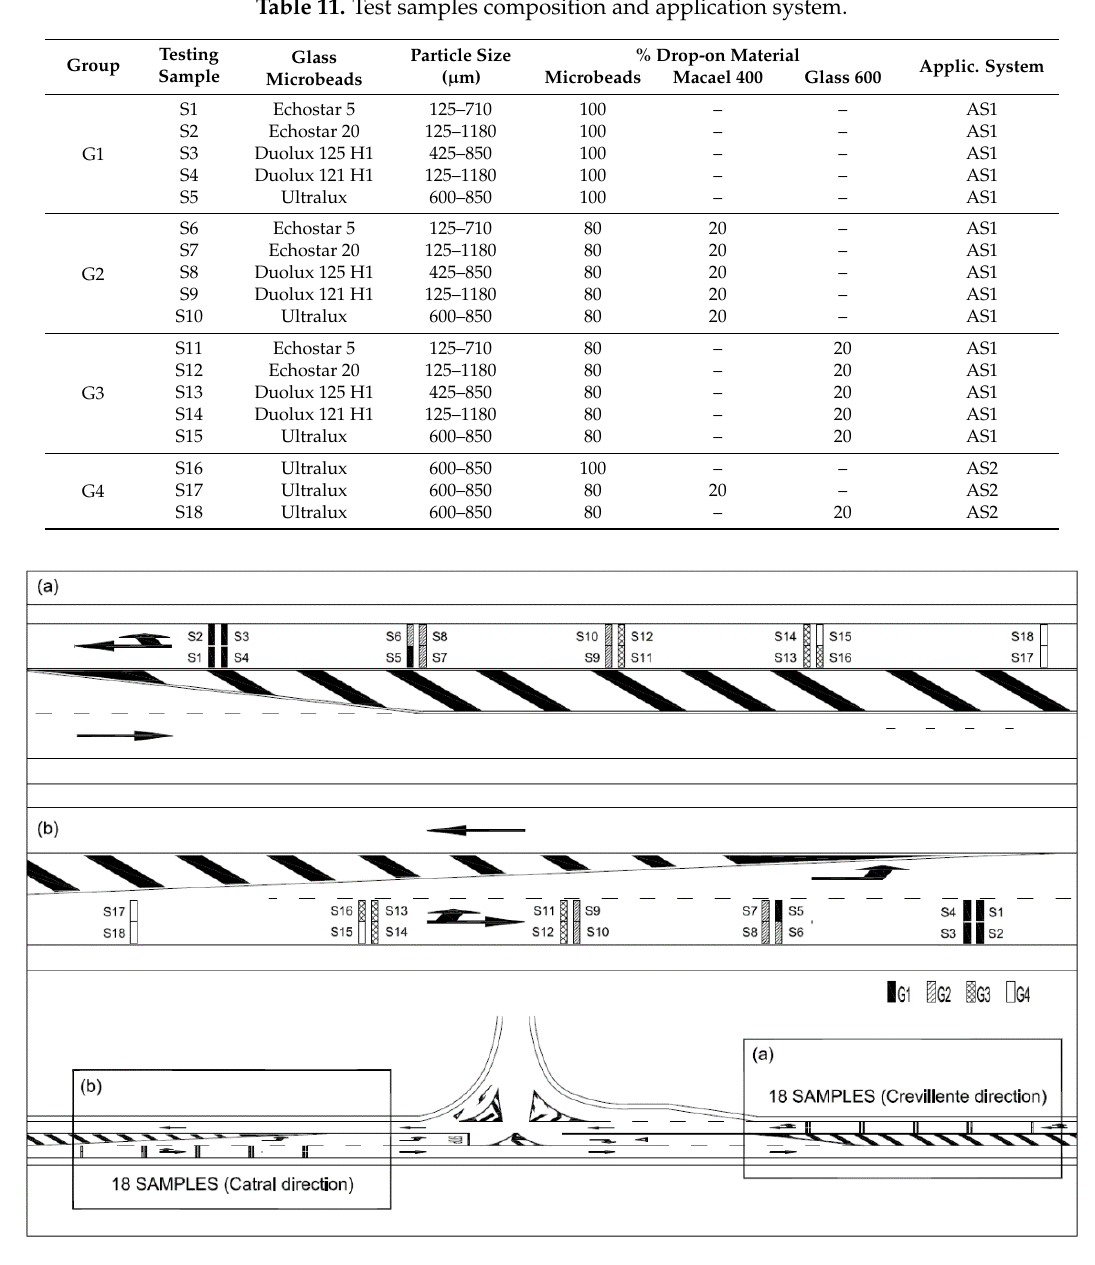
Figure 3. Testing samples labelling: ( a ) Crevillente direction; ( b ) Catral direction.